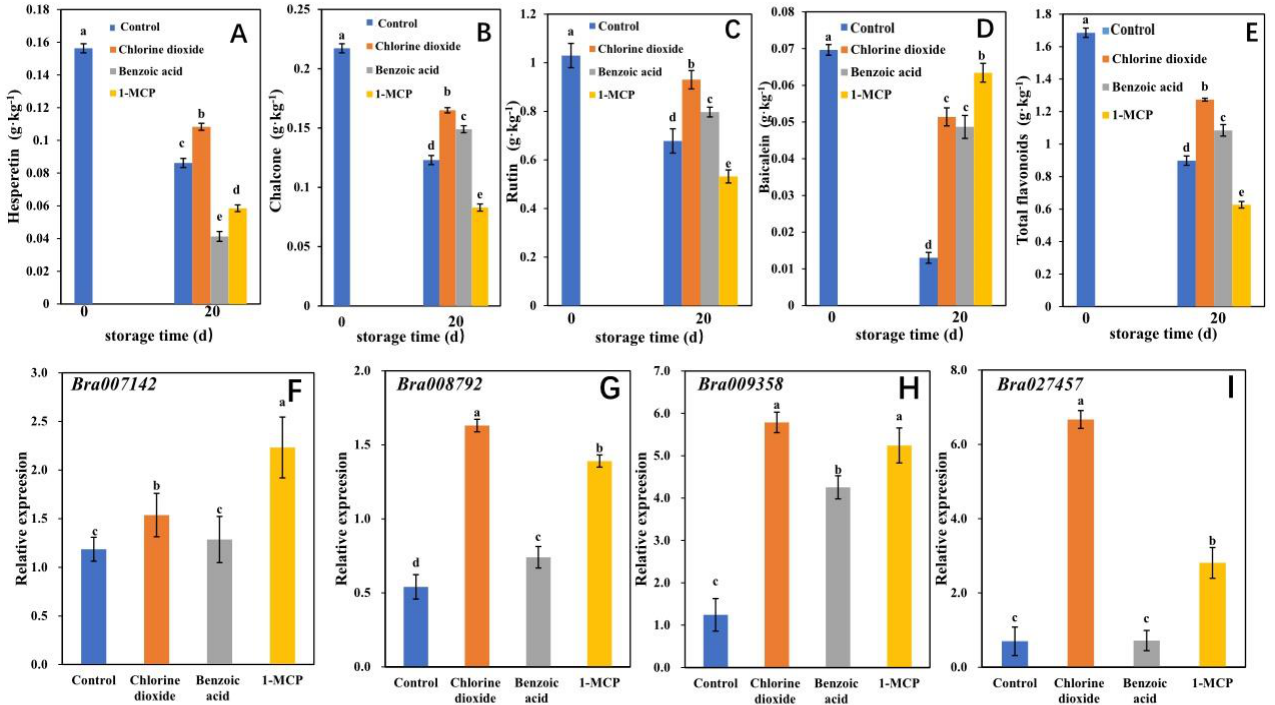
Figure 6. The concentrations of hesperetin ( A ), chalcone ( B ), rutin ( C ), baicalein ( D ), and total flavonoids ( E ) in postharvest flowering Chinese cabbage treated with benzoic acid, chlorine dioxide, and 1-MCP after storage. The gene expression of Bra007142 ( F ), Bra008792 ( G ), Bra009358 ( H ), and Bra027457 ( I ) in flowering Chinese cabbage treated with benzoic acid, chlorine dioxide, and 1-MCP. The vertical bars show the standard error of the mean ( n = 3). The different letters indicate statistically significant differences for each group ( p < 0.05).